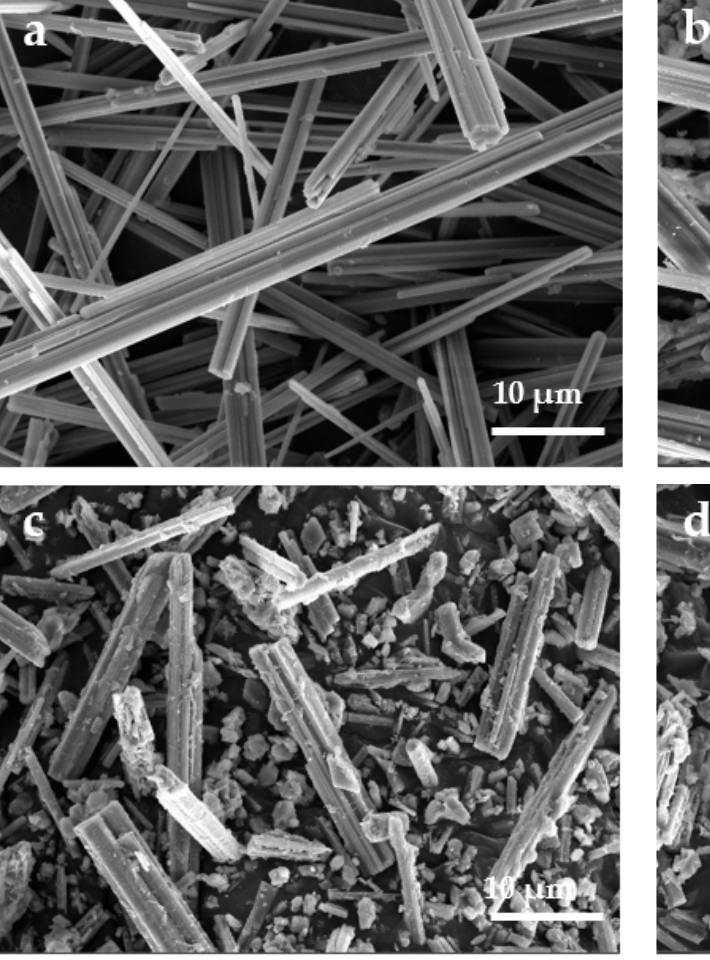
Figure 4. The thermogravimetric curves for ( a ) untreated CSWs, ( b ) CSW-OH, ( c ) CSW-OH-KH570, and ( d ) CSW-g-PMMA.